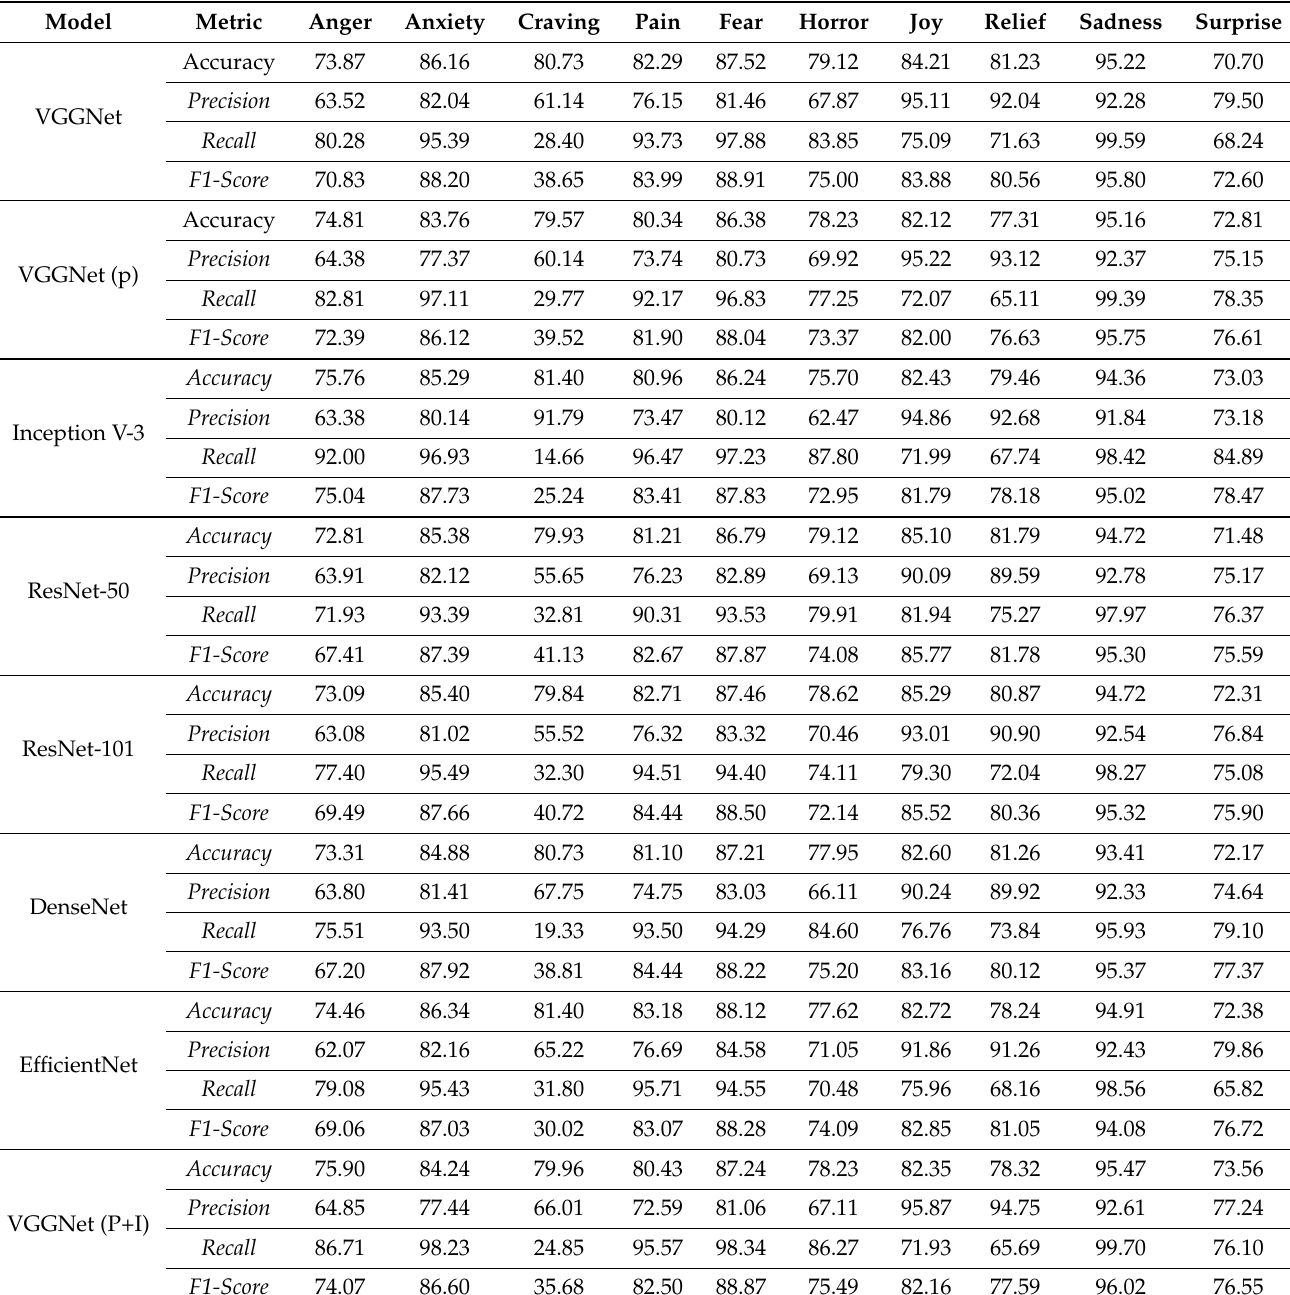
Table 11. Experimental results of the proposed visual sentiment analyzer on task 3 in terms of accuracy, precision, recall, and F1-score per